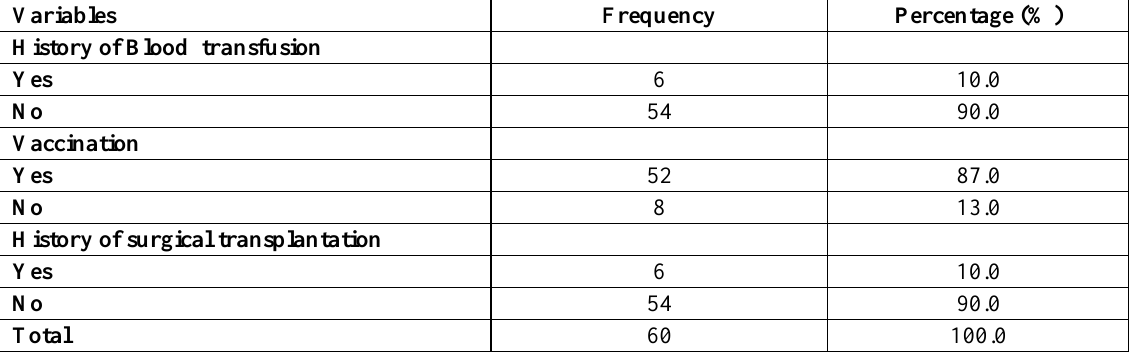
Table 3. Distribution of study group according to history of blood transfusion, surgical transplantation and vaccination status.